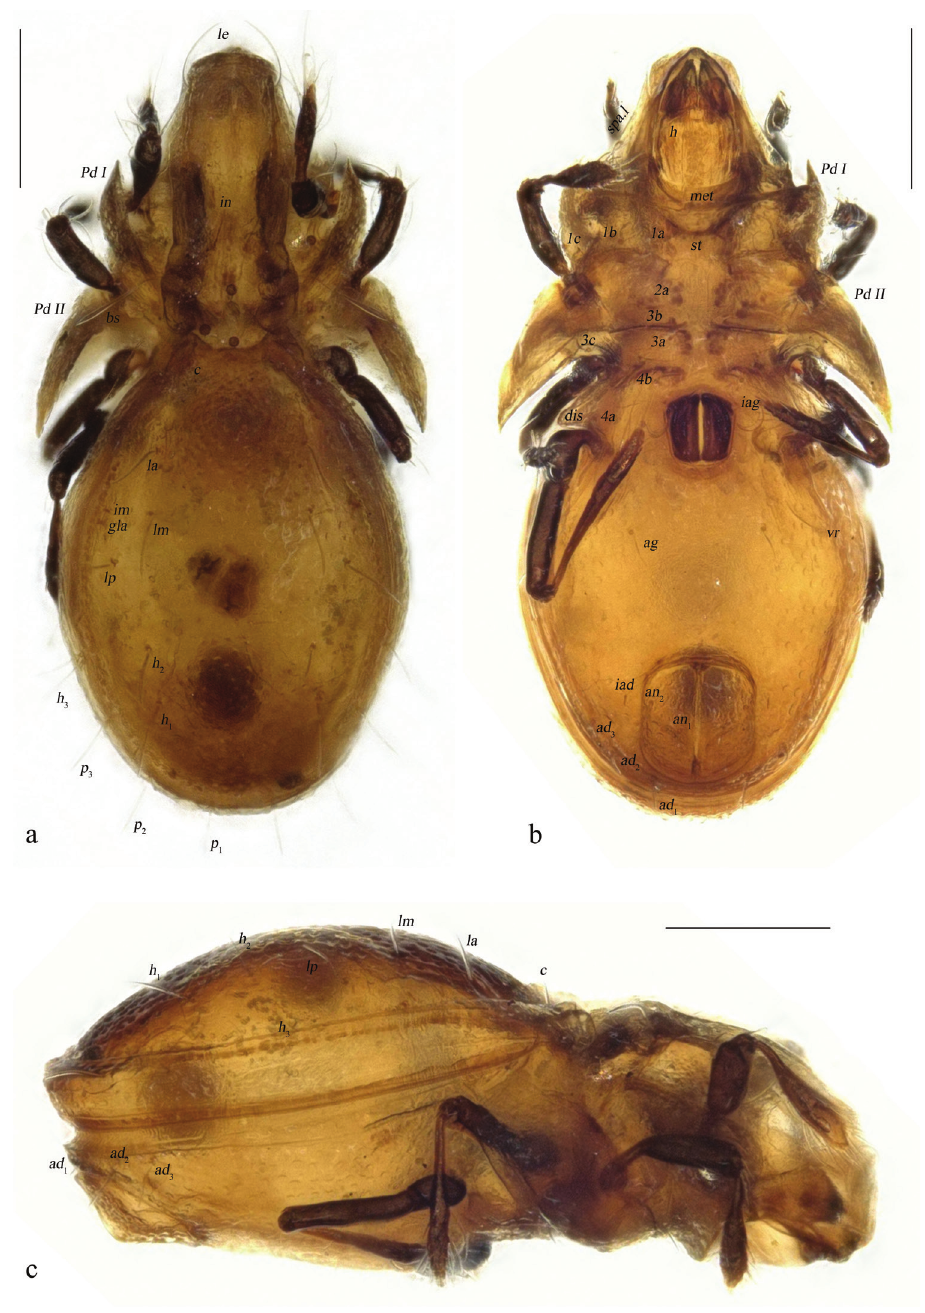
Figure 10. Eurostocepheus (Eurostocepheus) aquilinus Aoki, 1965, adult, microscope images: a dorsal view b ventral view c lateral view. Abbreviations and notations explained in text. Scale bars: 200